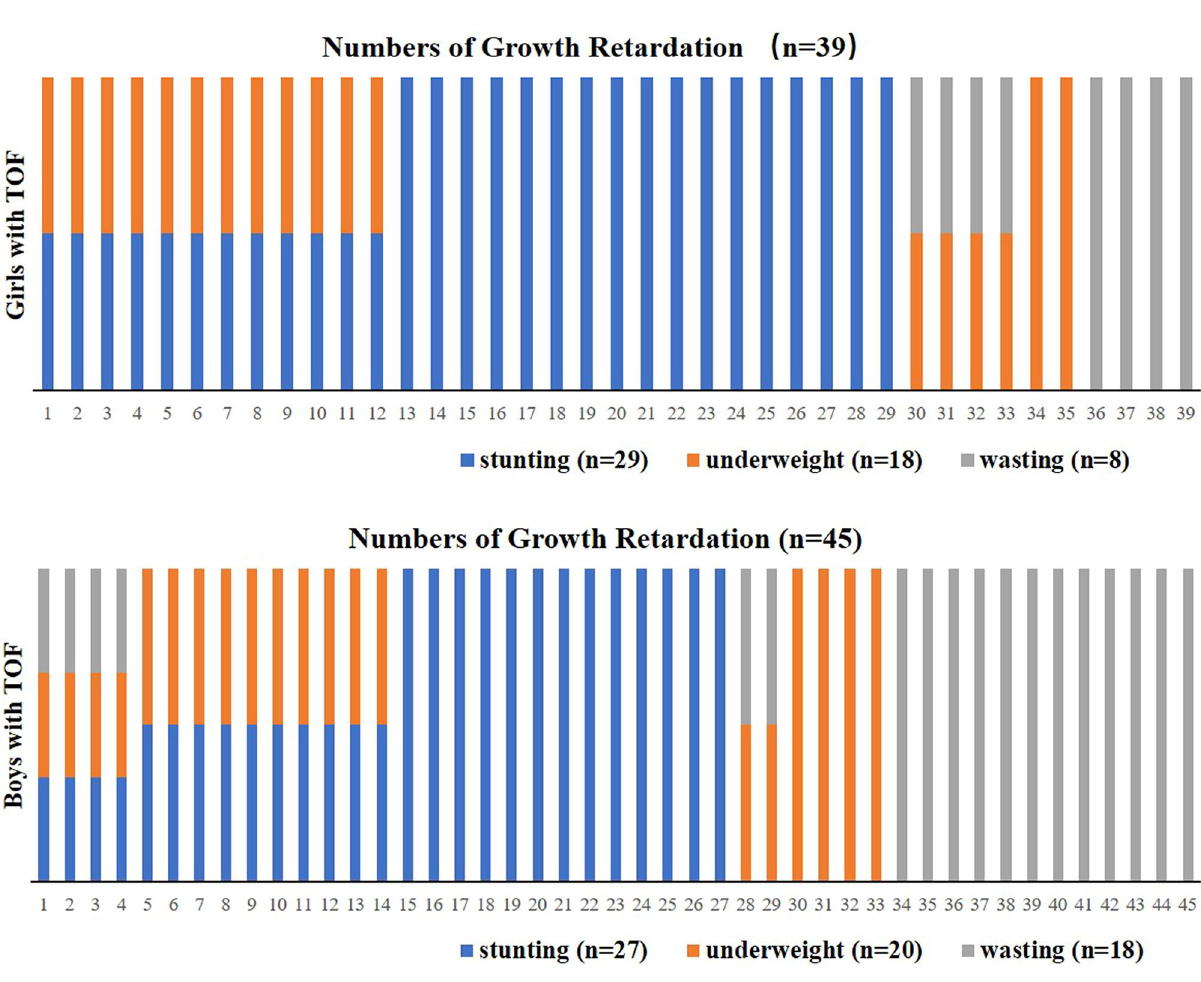
Figure 3. Schematic summary of growth retardation pattern distribution in TOF patients. The number of each growth retardation pattern in the 124 girls and 138 boys with TOF were calculated based on the original data and